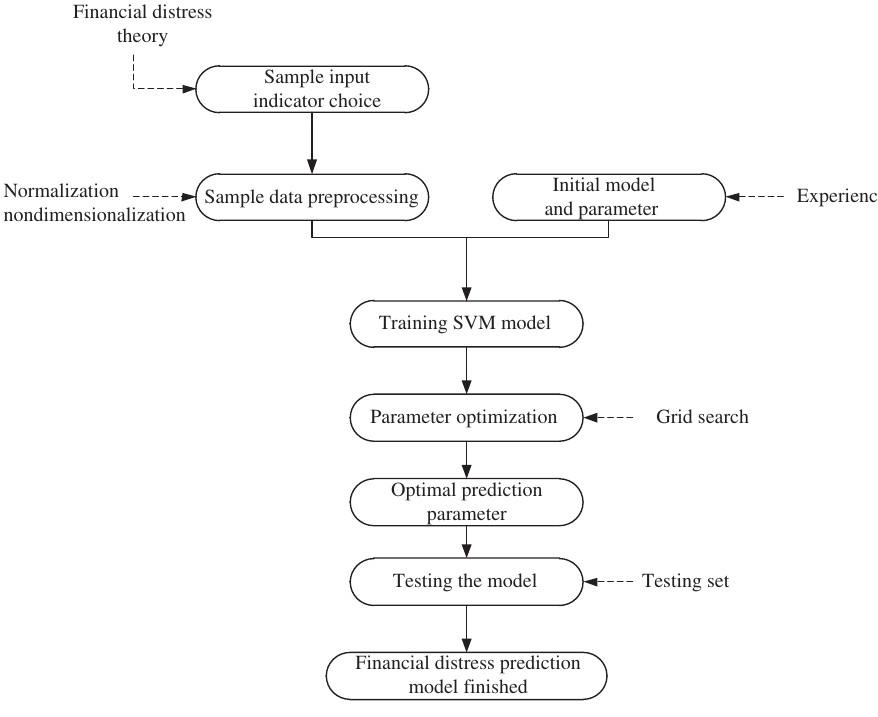
Figure 1: The Traditional SVM Financial Distress Prediction